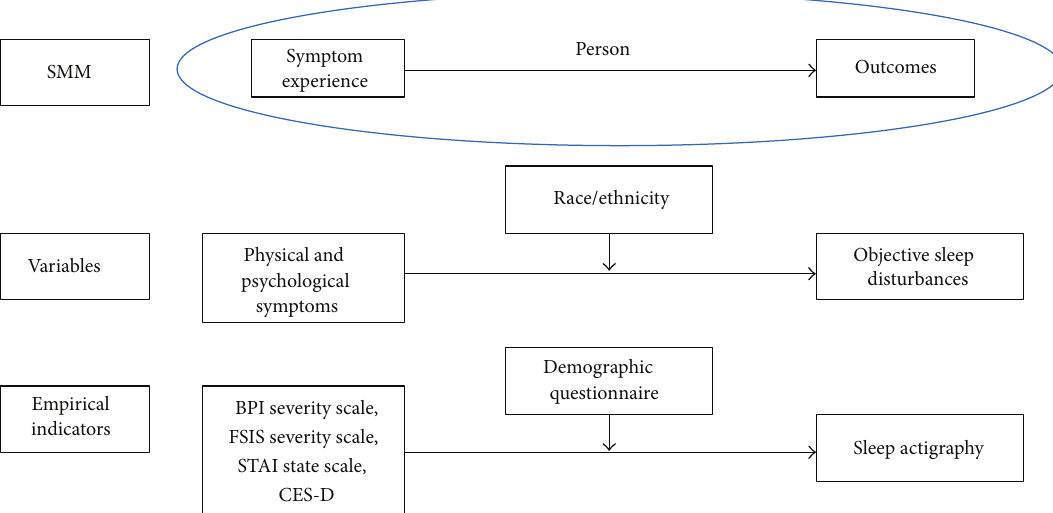
Figure 1: Conceptual framework of the study. The symptom experience was the perception and evaluation of physical and psychological symptoms; the outcome was objective sleep disturbances. This model tested whether theperson domain, specifically thedemographic variable of race/ethnicity, modified the relationship between the dimensions of symptom experience and outcomes. BPI: Brief Pain Inventory Short Form; CES-D: Center for Epidemiological Studies Depression Scale; FSI: Fatigue Symptom Inventory; SMM: Symptom Management Model; STAI-S: State Trait Anxiety Inventory-State Scale only. Adapted from Humphreys et al.